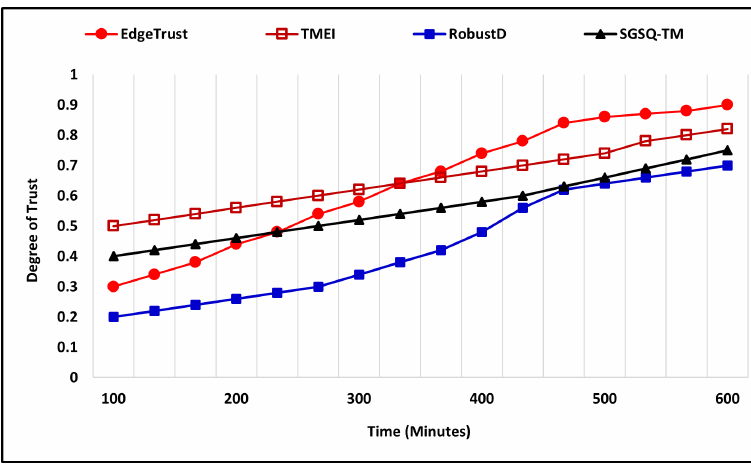
Figure 12. Bad mouthing attacks in Scenario-1.